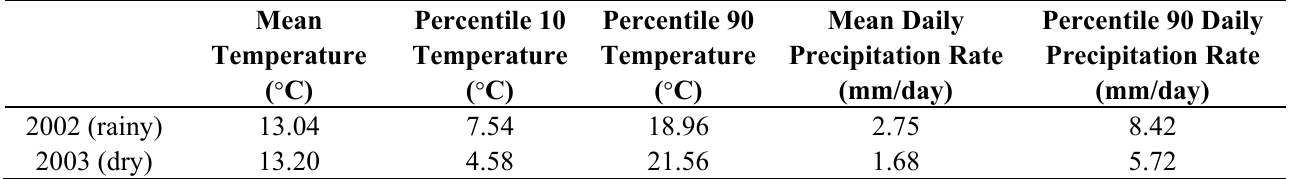
Table 2. Characteristic temperatures and precipitation rates of historical data sets.